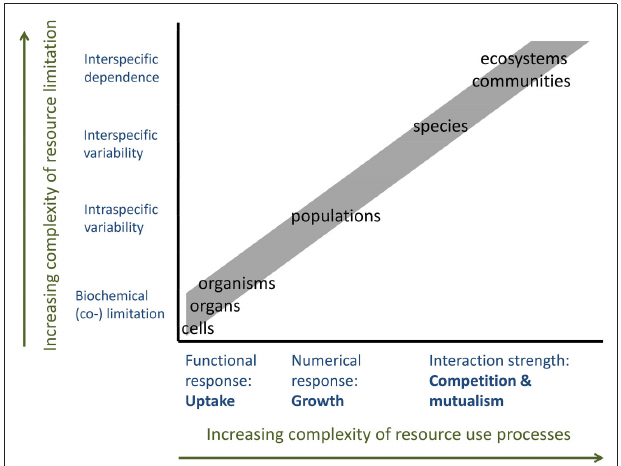
FIGURE 5 | Resource use and resource demand depending on organizational levels from single cells to ecosystems. Increasing complexity of resource use processes and types of resource limitation decrease the predictability of RUE by up or downscaling across levels of